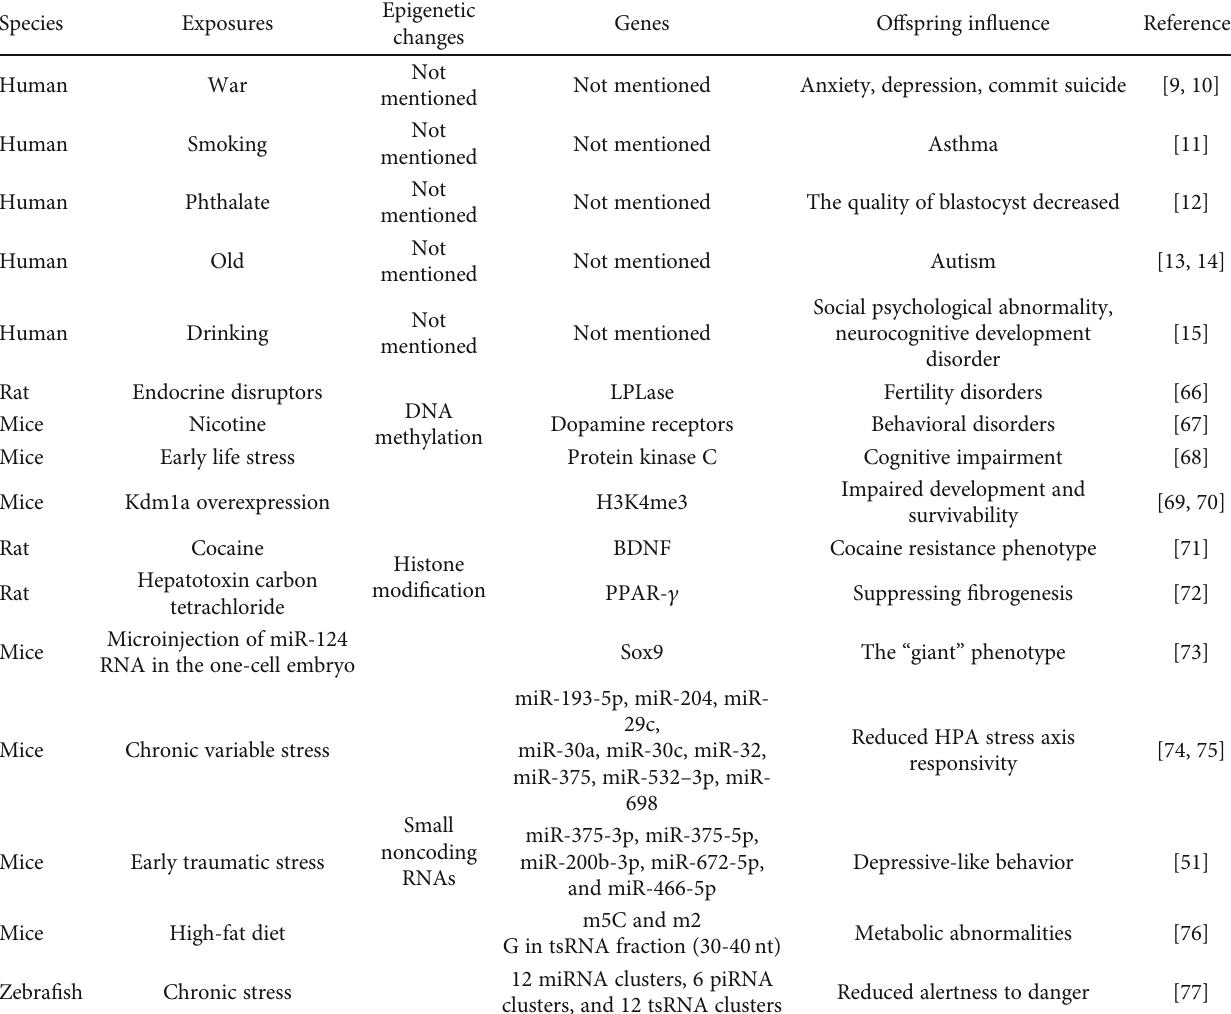
Table 1: Summary information of the relationship between environmental exposures, sperm epigenetic changes, genes, and o ff spring in fl